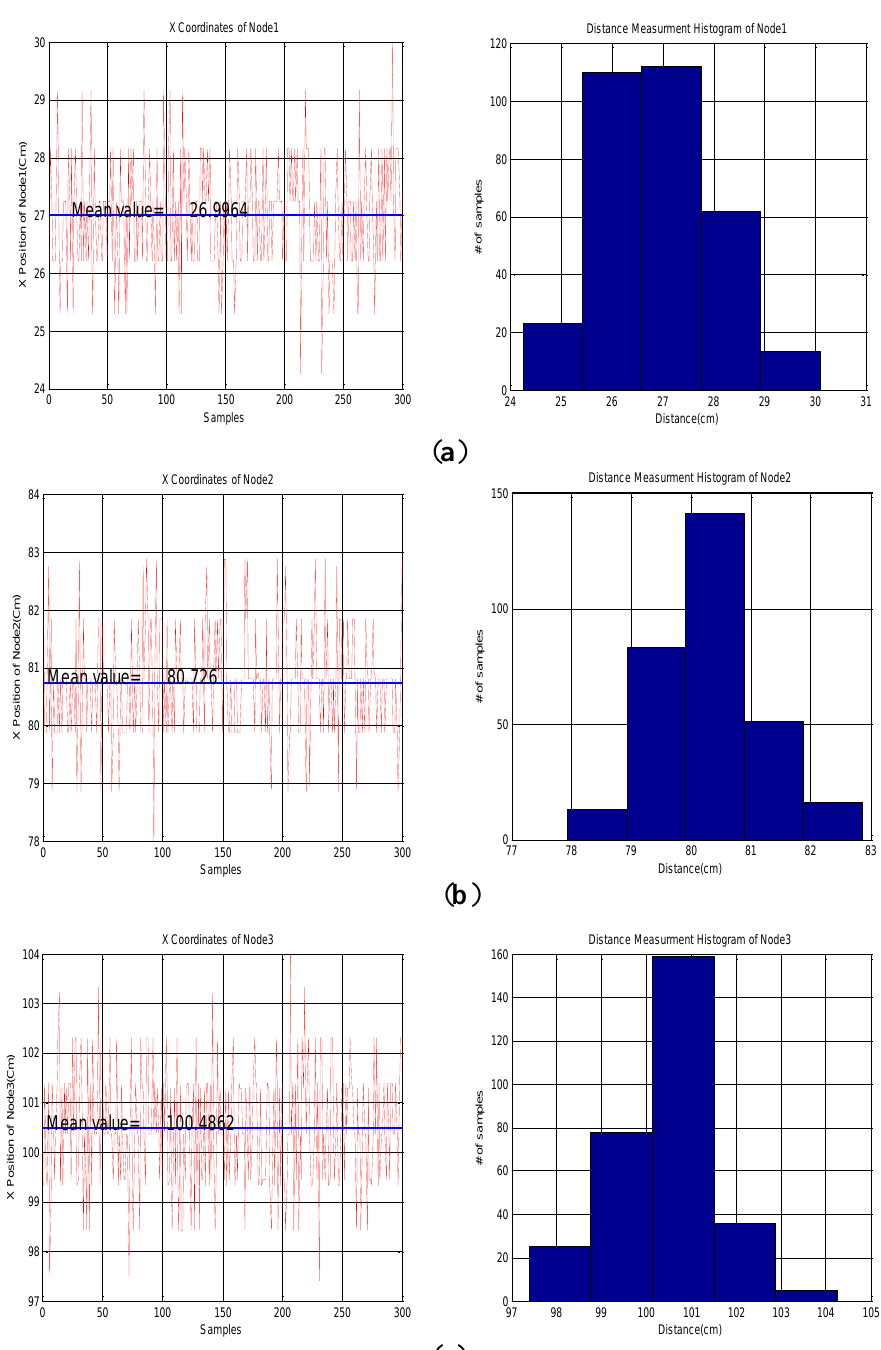
Figure 6. Measured distance data. ( a ) Node l: (27 cm, 0 deg), ( b ) Node 2: (80 cm, 0 deg) , ( c ) Node 3: (100 cm, 0